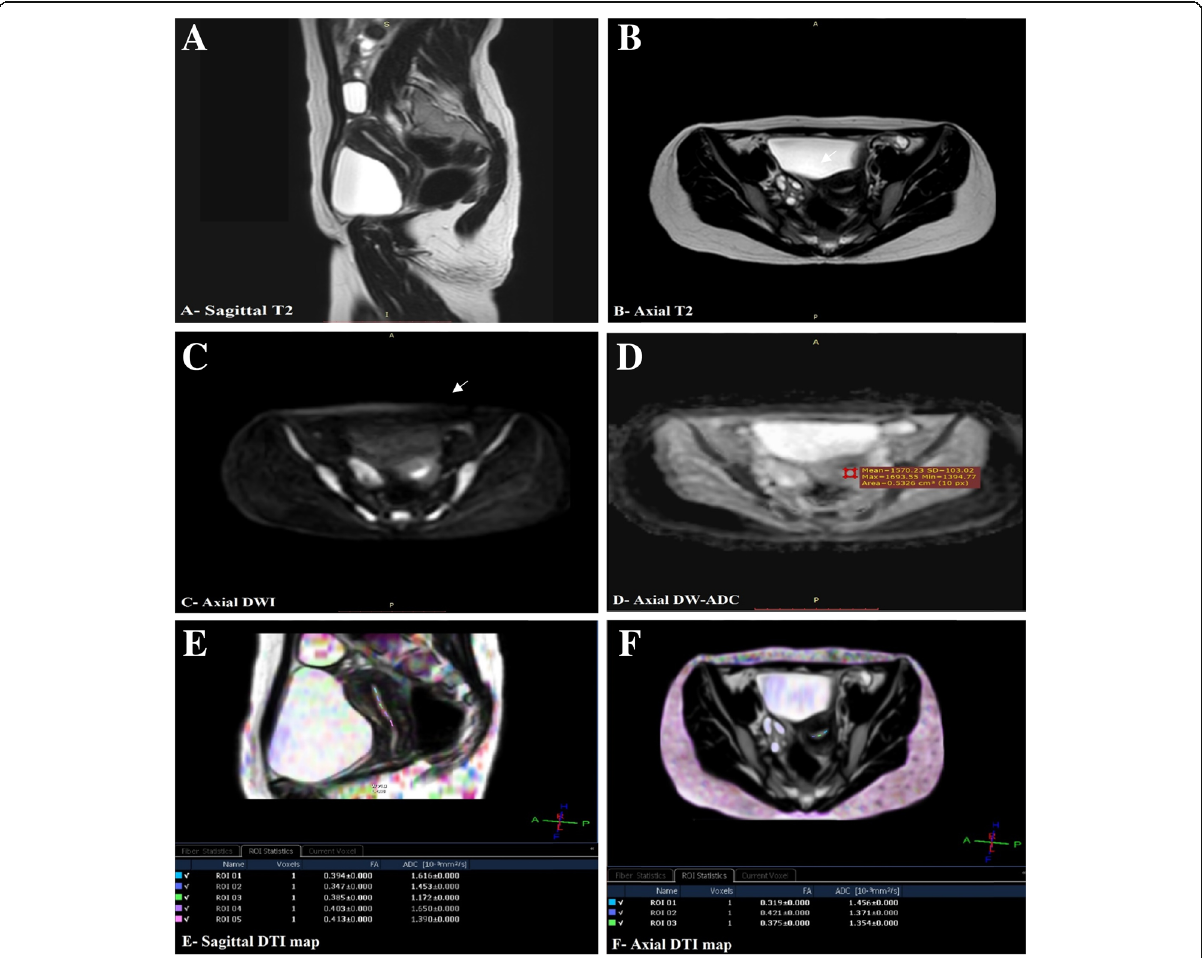
Fig. 1 A 24-year-old premenopausal female with endometrial thickness 6mm by TVS. a , b Sagittal and axial T2WIs show normal zonal anatomy of the uterus. The central hyperintense stripe represents the endometrium (arrows); the band of low SI subjacent to the endometrial stripe represents the junctional zone (red stars). The outer myometrium is of intermediate SI (OM). c Axial DWI with b value of 1000s/mm 2 shows normal appearance of the endometrium with high signal intensity (arrow). d Axial DW-ADC map image shows normal appearance of the endometrium with intermediate signal intensity. Mean DW-ADC value = 1.570 × 10 − 3 mm 2 /s. e , f Sagittal and axial DTI map images demonstrate values of DT-FA and DT-ADC (MD) in multiple ROI along the endometrial stripe. Mean DT-FA value = 0.382, and mean DT-MD value = 1.433 × 10 − 3 mm 2 /s. Diagnosis: normal